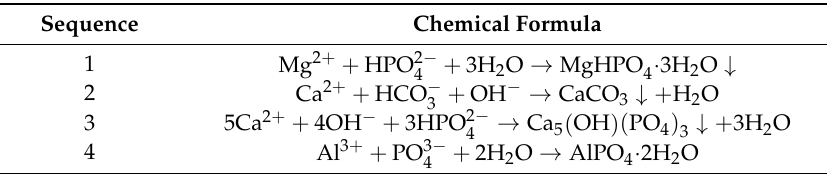
Figure 9. The comparison of different type of P before and after test. Table 10. Formation of P